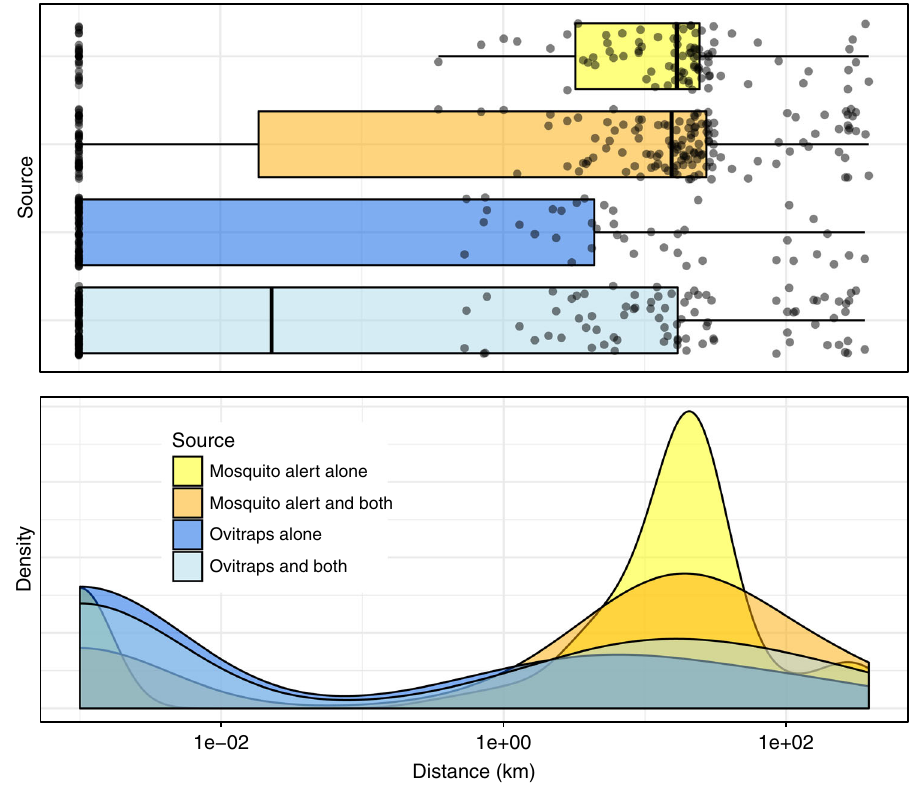
Fig. 3 Distributions of distances between known tiger mosquito invasion front and new municipalities in which tiger mosquitoes were detected in 2014 – 2015. New municipalities are divided into those in which Mosquito Alert is alone credited for the detection (yellow), those in which Mosquito Alert is alone credited combined with those in which both Mosquito Alert and ovitraps are credited (in other words, all municipalities in which Mosquito Alert is credited; orange), those in which ovitraps are alone credited (dark blue), and those in which ovitraps are alone credited combined with those in which both are credited (in other words, all those in which ovitraps are credited; light blue). All distances calculated between municipality boundaries, using shortest distance to invasion front, and shown on x axis using log-scale to improve visualization of long tails (1 m added to all 0-km distances). Top: boxplots with boxes encompassing central 50% of the data and central bars indicating medians. Whiskers extend to 1.5 times the inter-quartile ranges. Raw data shown with jittered black points. Bottom: Gaussian kernel density